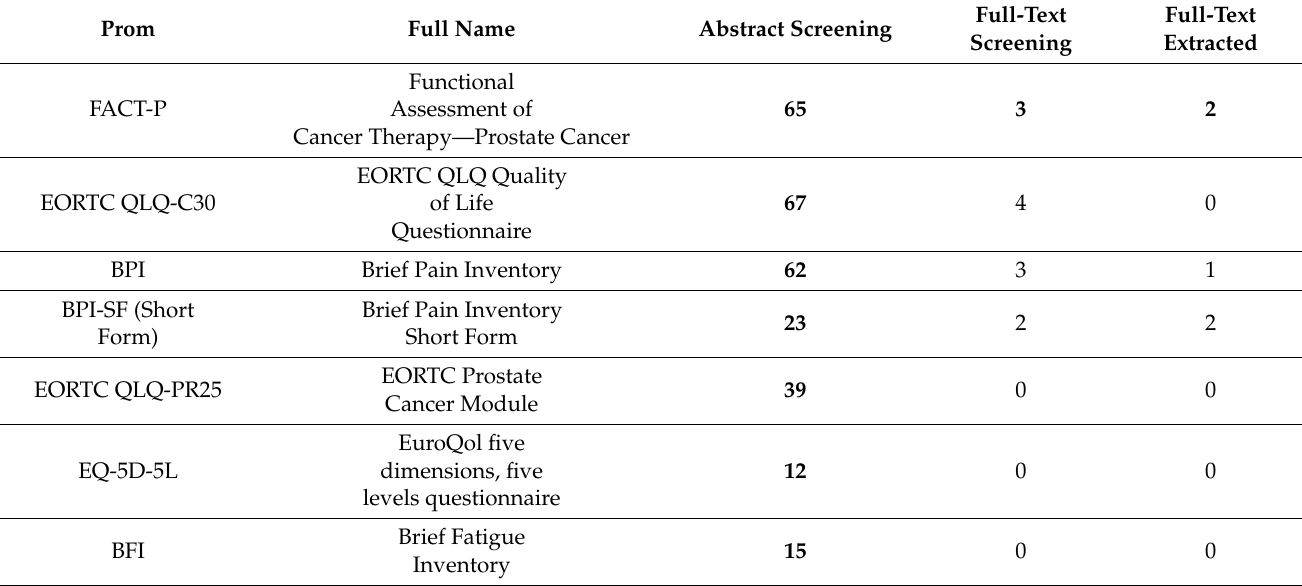
Table 3. Overview of the PROM instruments extracted after the screening